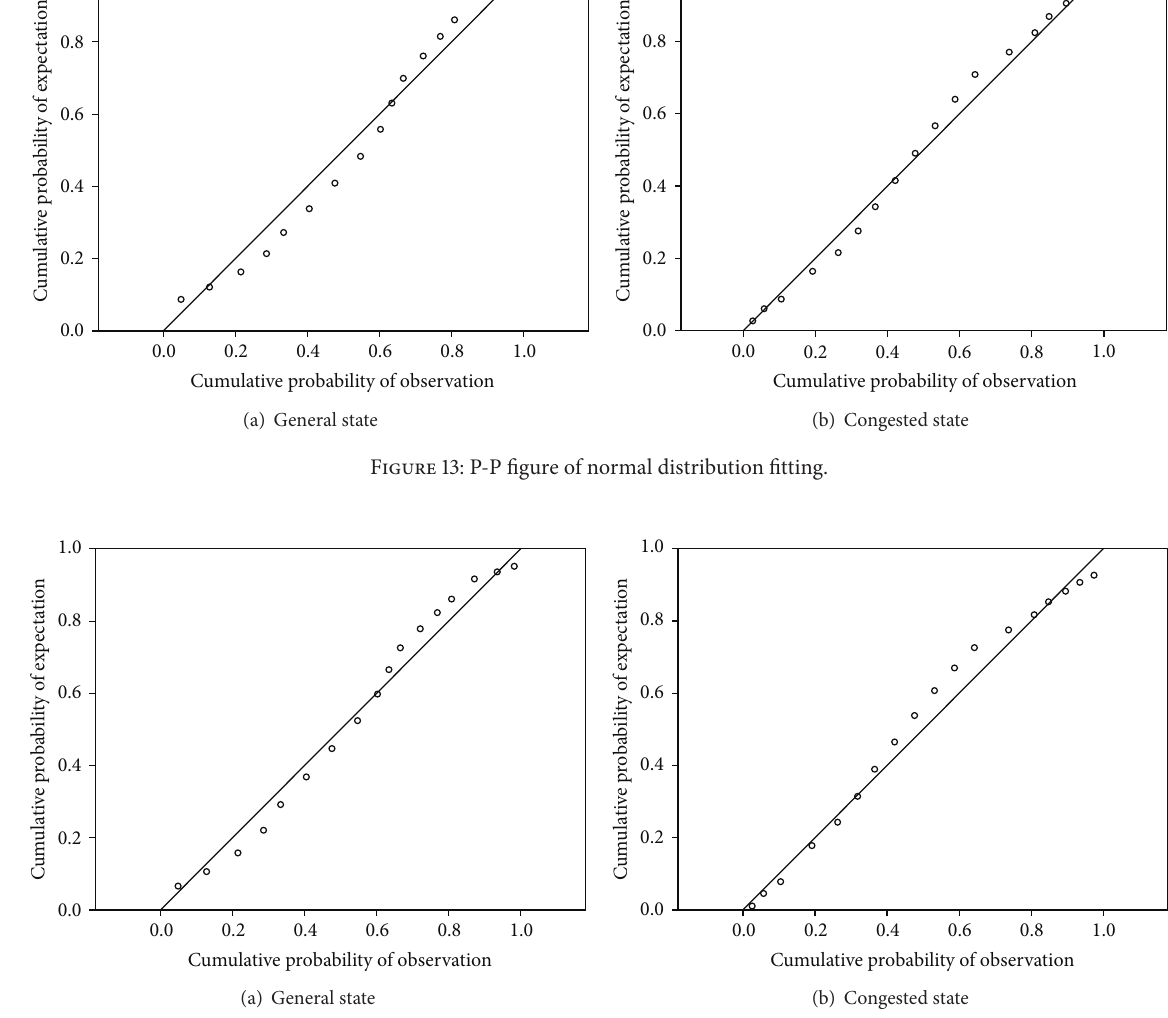
Figure 14: P-P figure of log-normal distribution fitting.